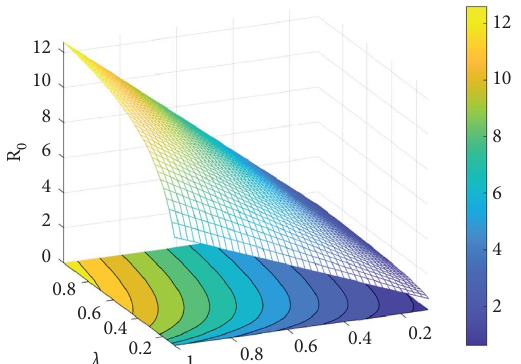
Figure 3: Te dynamics of sensitivity analysis with respect to parameters λ and b with R